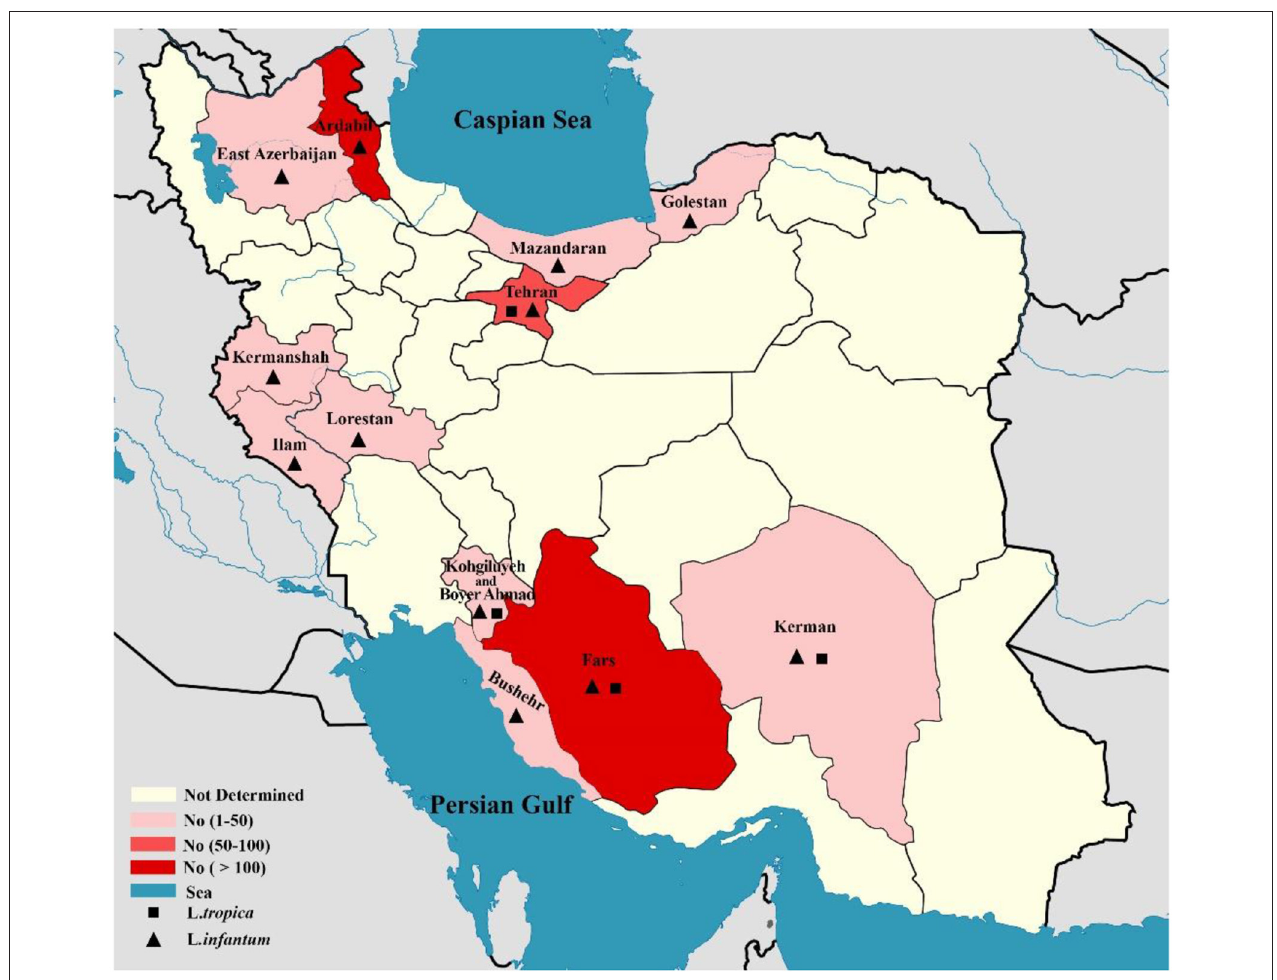
FIGURE 3 | Map of distribution of Leishmania spp. causing of visceral leishmaniasis using molecular methods in different geographical areas of Iran.